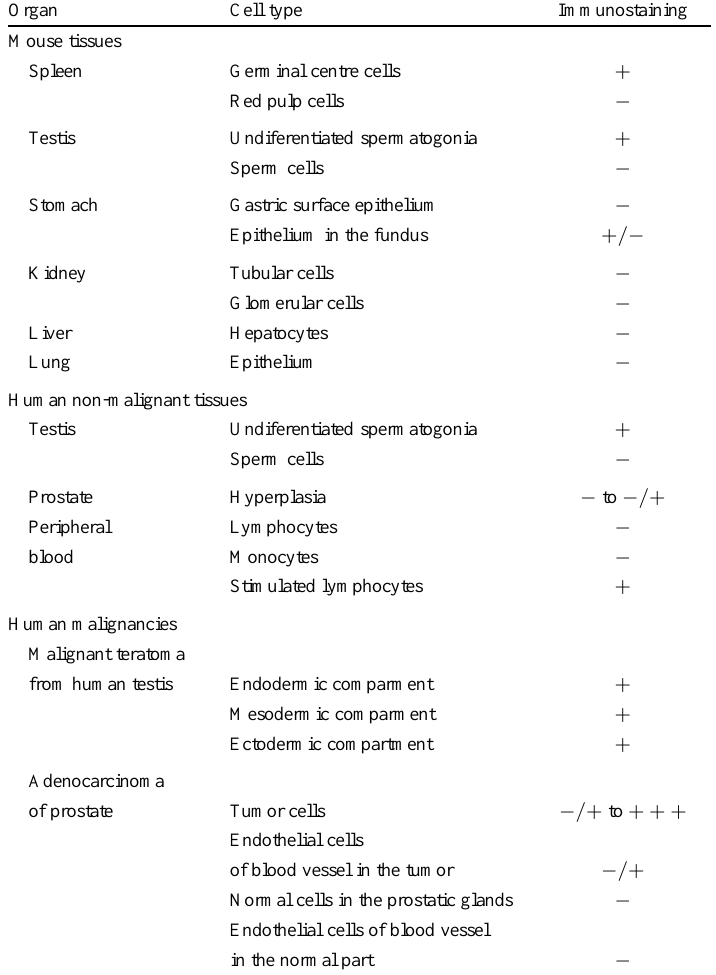
Cell types reacting with the anti TK1 antibody from mouse and human tissues Organ Mouse